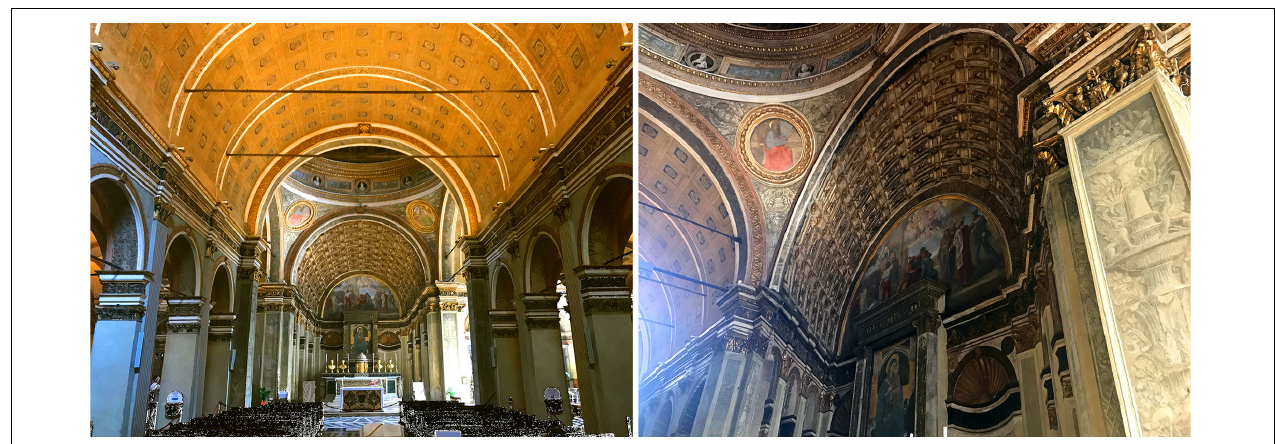
FIGURE 1 | Santa Maria presso San Satiro, Milan, was completed by Donato Bramante in 1482. The first view shows the built nave in the foreground (picture on the left). When approaching, the chancel’s interior disappears giving view to a relief painting inside the arch segment behind the altar.